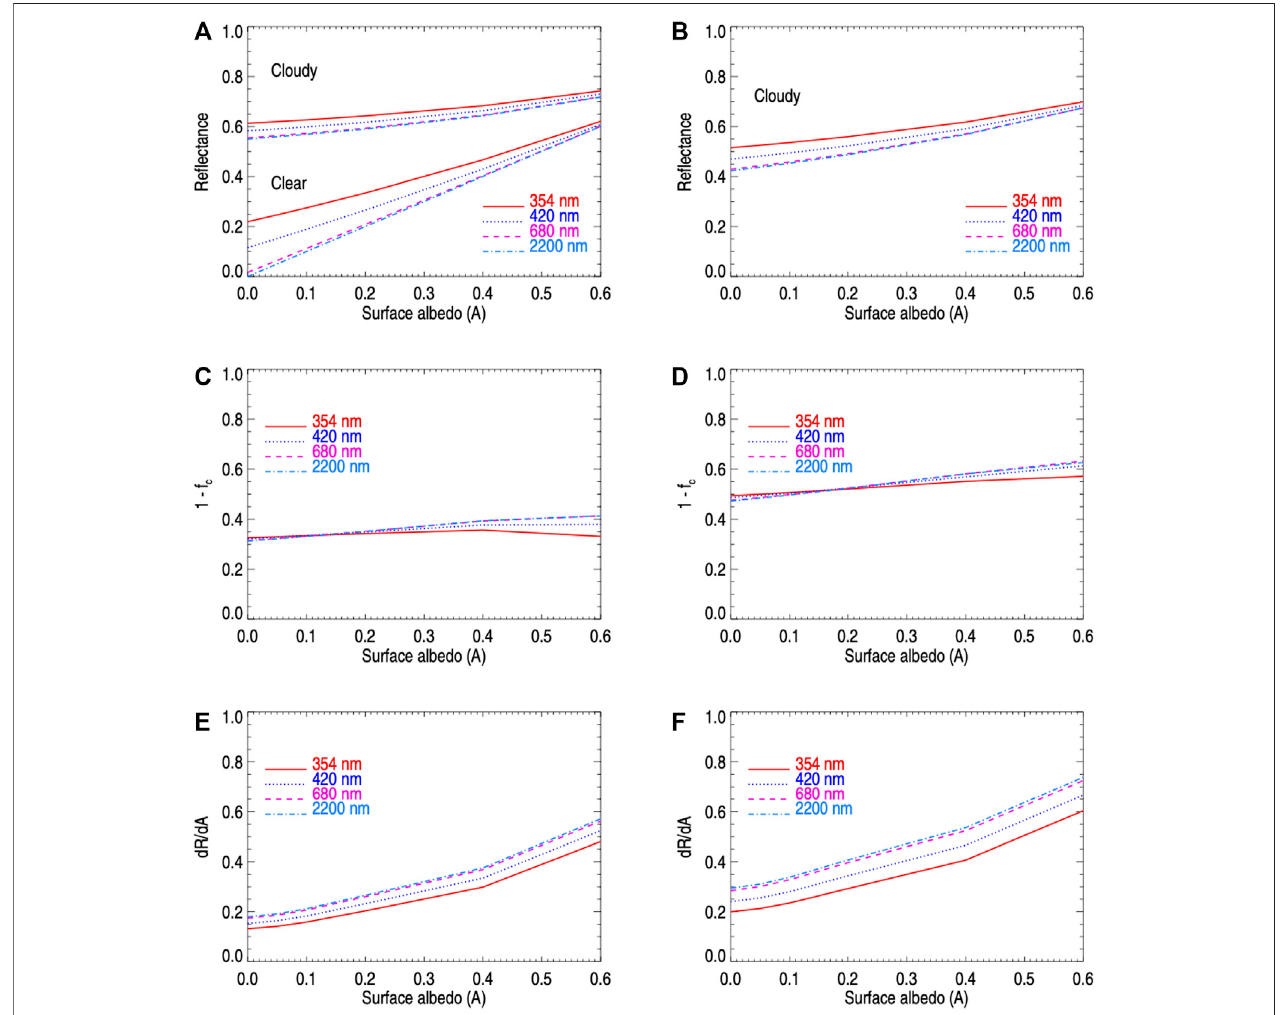
FIGURE 4 | Radiative transfer calculations for nadir and solar zenith angle of 45 ° for an ice cloud model (left panels) and C1 model (right panels, see text for more detail) showing re fl ectance (R) for cloudy cases with cloud optical thicknesses of 10 in A and B (clear sky calculations also in panel A); one minus the effective cloud fraction, f c , in C, D; and the sensitivity of the re fl ectance to a unit change in surface albedo (A), denoted dR/dA as a function of surface albedo for four wavelengths spanning the ultraviolet through short-wave infrared.